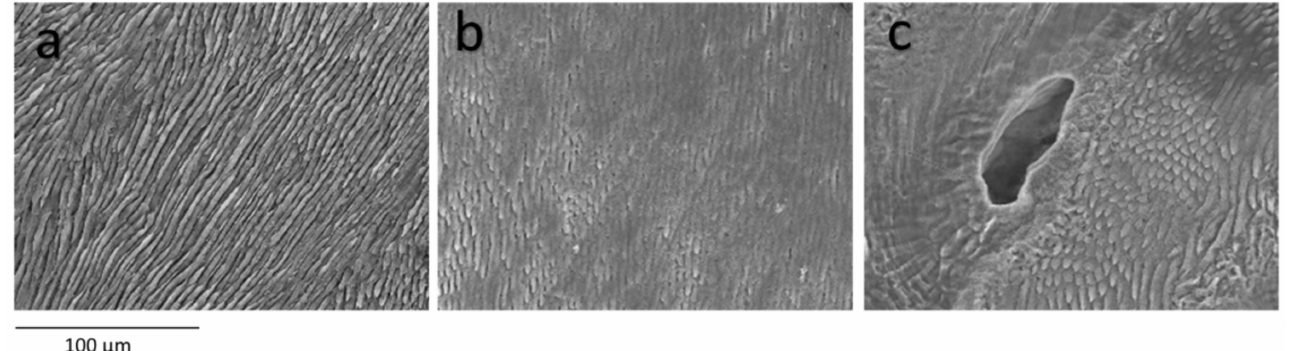
Figure 1. Enamel. SEM photomicrographs at 500 × magnification ( a – c ). Enamel without morpholog- ical alterations, from a control tooth ( a ), enamel with alterations in the prismatic structure ( b ) and enamel with alterations in the prismatic structure and the inclusion of an ovoid structure inside ( c